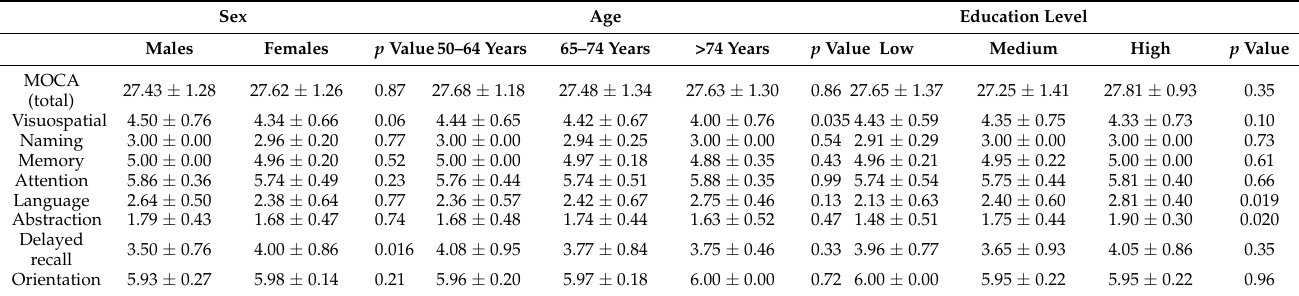
Table 3. Effects of characteristics of subjects on MoCA total score and its sub-domains in healthy